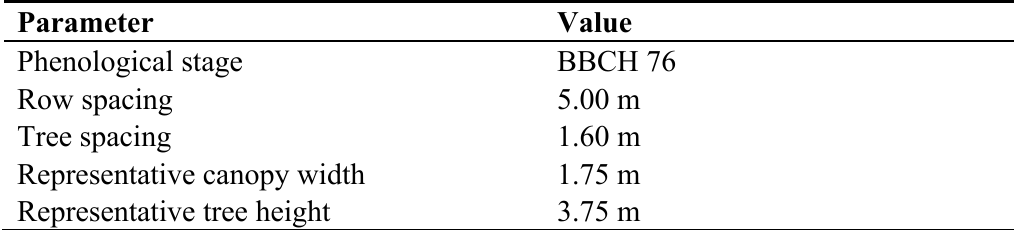
Table 2. Characteristics of the Malus domestica , Borkhausen cv. ‘Golden Delicious’ apple orchard where the field trials were carried